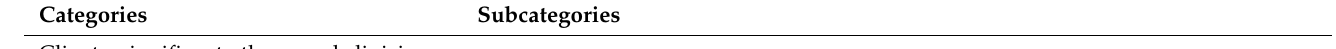
Table 2. Theme 1. With experience and clear expectations, users believe WMS can make a